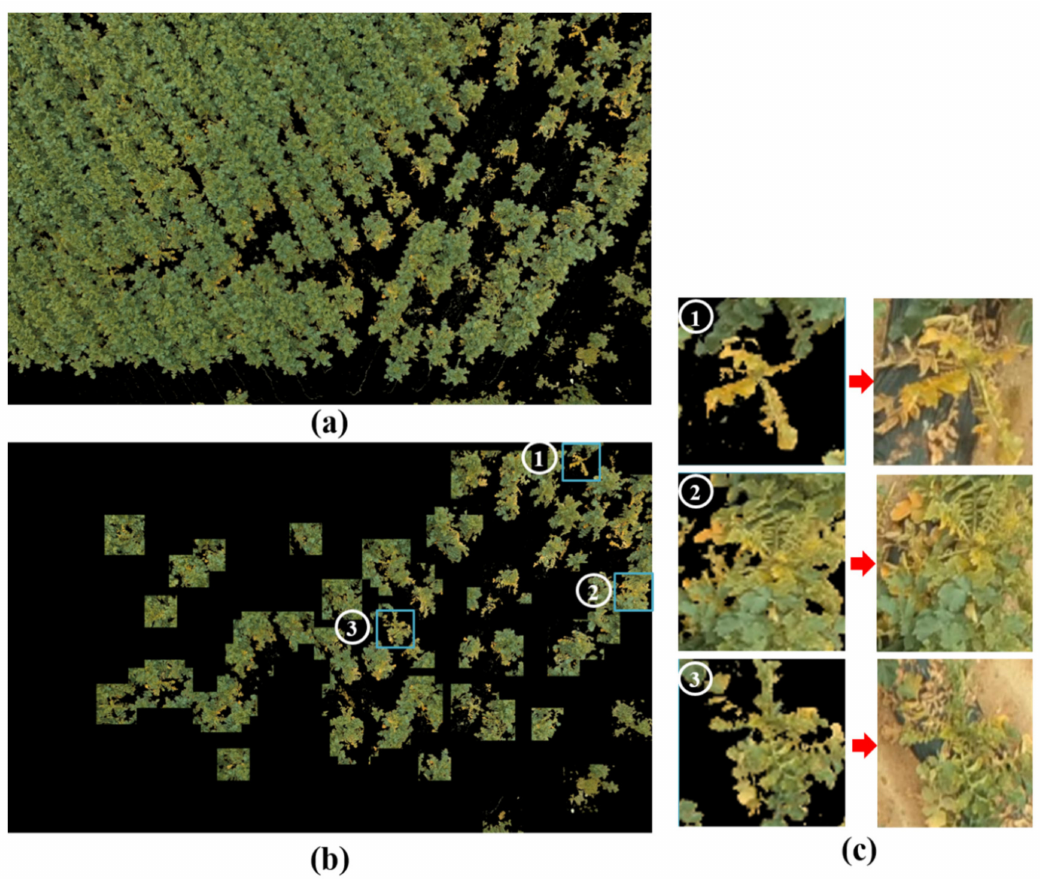
Figure 10. Example of the radish field classification and disease severity analysis on the RGB image, including ( a ) extracted radish region from the RadRGB model, ( b ) wilt severity analysis with the blue box indicate some examples of the wilt region, and ( c ) comparison between detected wilt regions and original images (scaled up to 150% from ( b